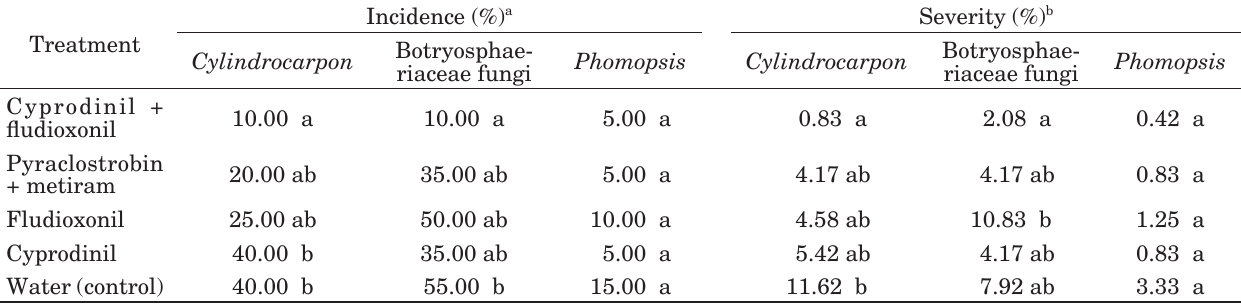
Table 2. Effects of selected fungicides on the incidence and severity of Cylindrocarpon, Botryosphaeriaceae and Phomopsis in naturally infected grapevine plants grown in a nursery fi eld without a previous history of grapevine